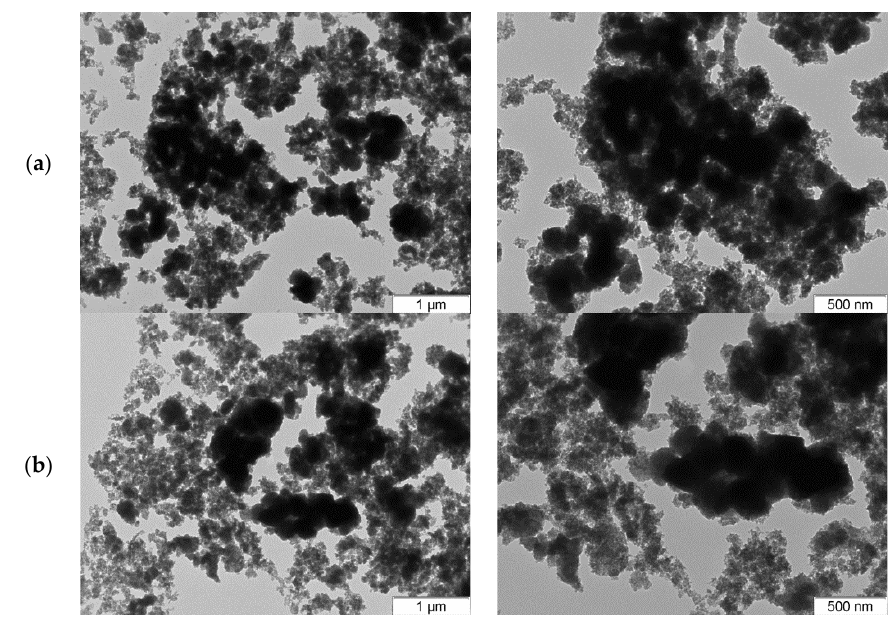
Figure 10. TEM images of a-TiO 2 -based NPs (( a ) TiO 2 and ( b ) TiO 2 -NH 2 ).